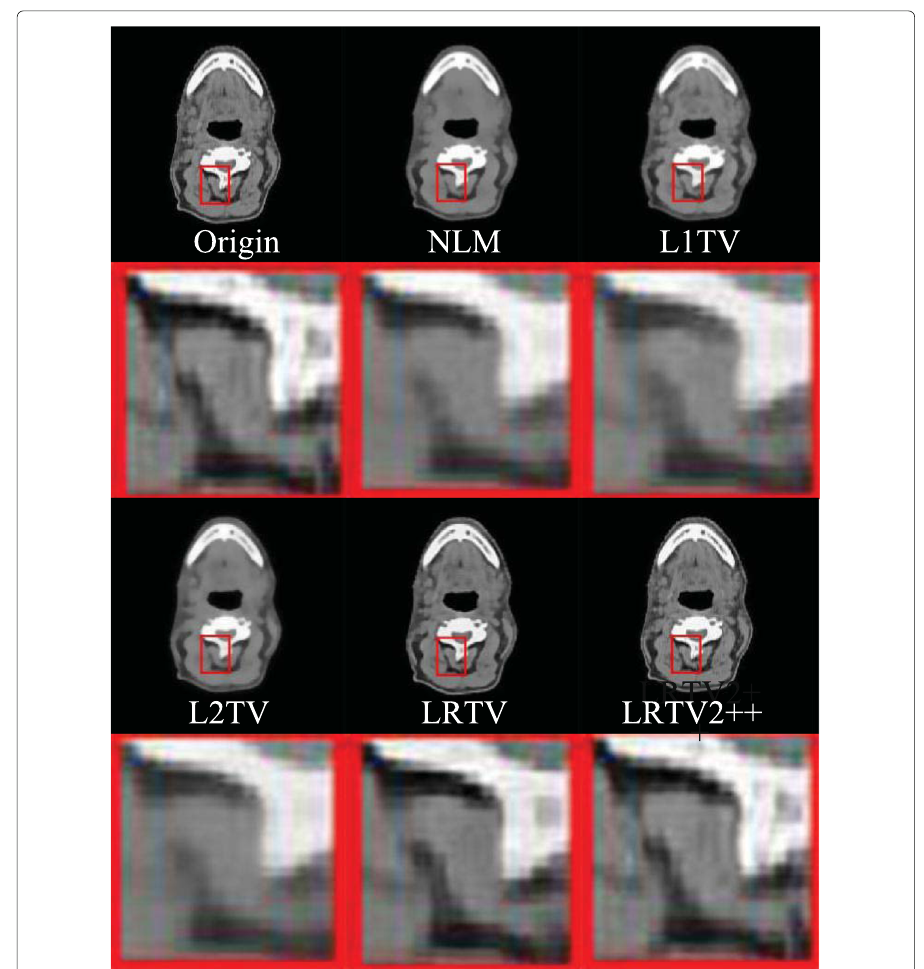
Fig. 4 The performance of recovered images of different methods and enlarged regions (12-08-2009-RTHEADNECK